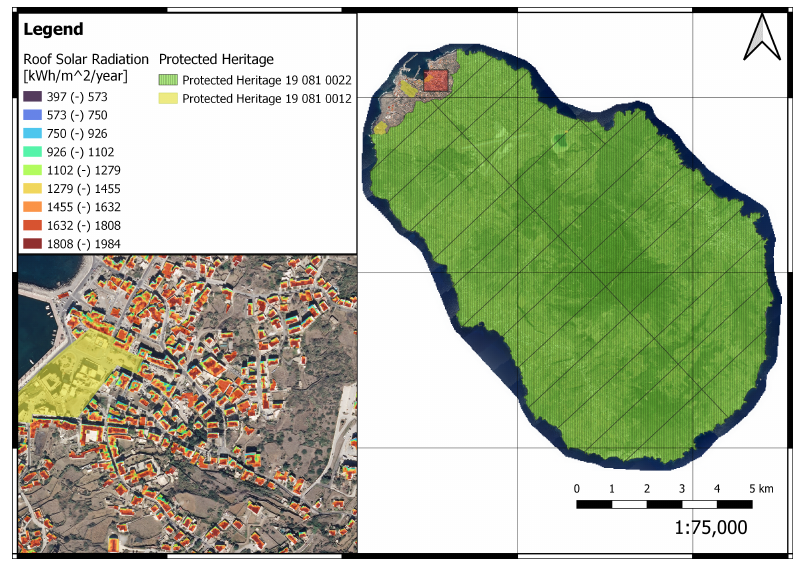
Figure 18. Solar radiation on Pantelleria roofs.